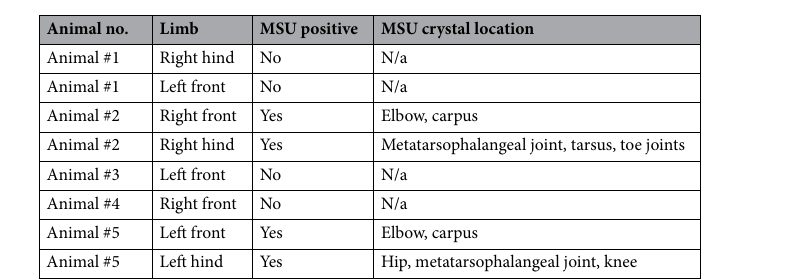
Table 1. Overview of the MSU crystal analysis findings and crystal deposition sites of all excised animal limbs.